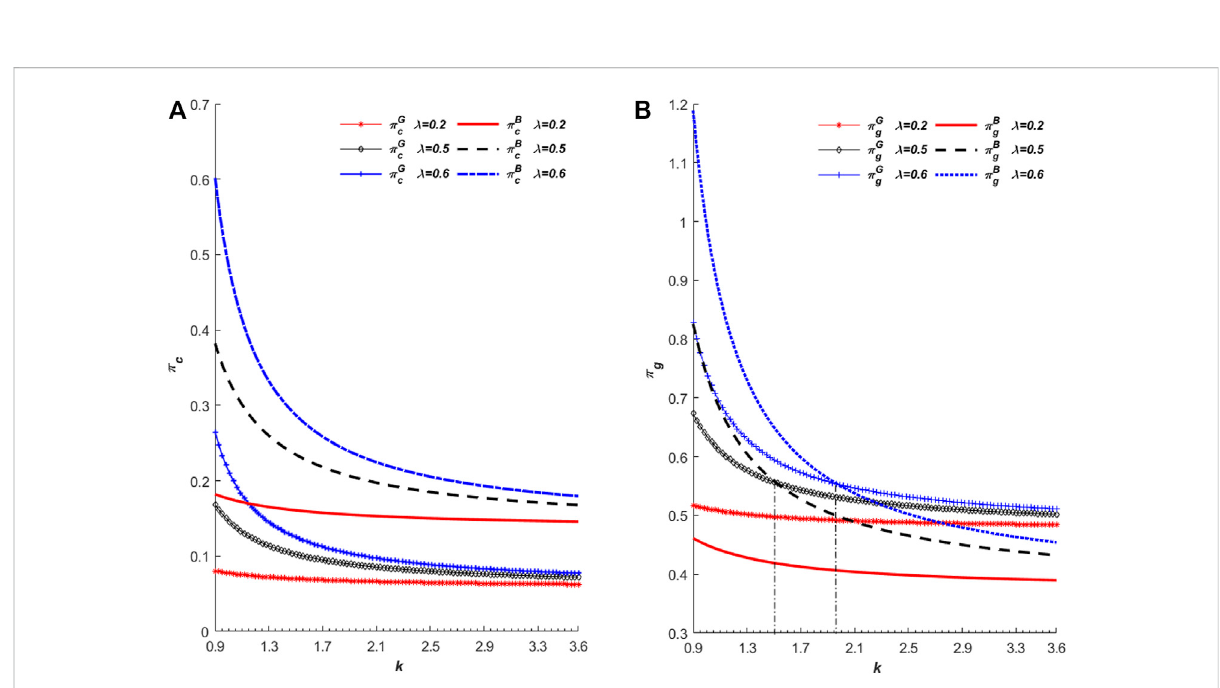
FIGURE 4 Effects of λ on (A) consumer surplus and (B) social